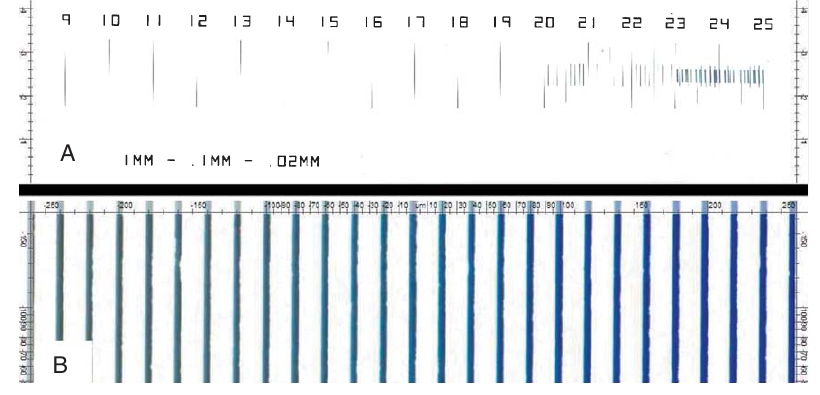
Fig. 1. A WSI (whole slide image) of a micrometer. To assess ImageScope’s TM measurement “ruler”, a micrometer was scanned using the Aperio XT. Panel A shows a low power view, with the measurement dimension key in the bottom left. Panel B is a high power image of the small hash marks on the right side of the ruler. The blue lines are spaced out every 20 microns. On the top of the image, is ImageScope’s TM ruler, which perfectly corresponds to the measurements on the micrometer.